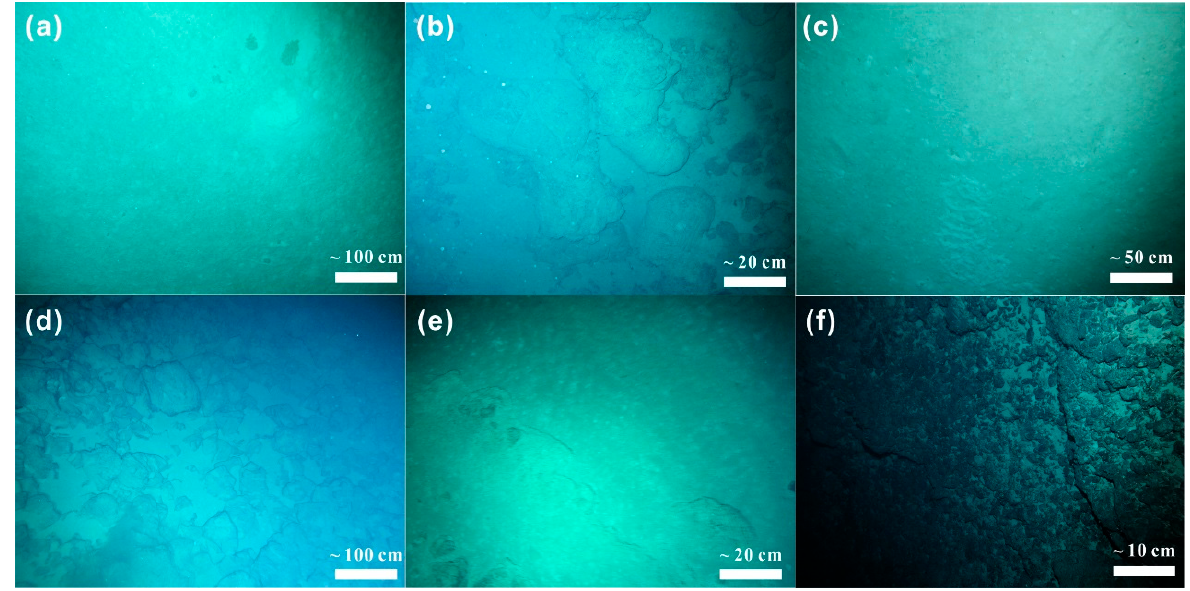
Figure 6. Typical seafloor photos below observed plumes. ( a ) Pelagic sediments below NL04-B plume. ( b ) Pillow lavas with few sediments cover below EL01 plume. ( c ) Pelagic sediments below WL02 plume. ( d ) Fragments of pillow lavas with sediment cover and ( e ) consolidated carbonate sediments below NL03 plume. ( f ) Breccia/debris with few sediments cover below WL03 plume.